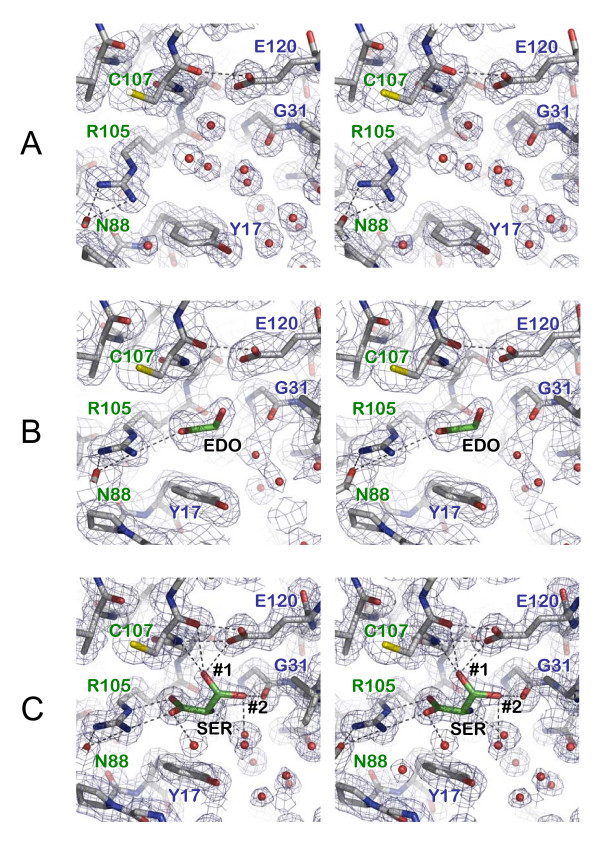
The ligand-binding pocket of TdcF in the empty, ethylene glycol-bound and serine-bound states. Stereoviews showing 2mFobs - dFcalc electron density maps contoured at approximately 1 sigma superposed on TdcF binding pockets in the following states: (A) empty (1.6 Å resolution); (B) with ethylene glycol bound (2.35 Å resolution); (C) with serine bound (1.6 Å resolution), where #1 and #2 denote alternate conformers for the Oγ. Important hydrogen bonds are shown as dashed lines. Residues from different subunits are labelled green and blue, respectively. In all cases, the side-chain of Arg-105 makes a bi-dentate interaction with the Oδ1 of Asn-88, which is just visible in the left foreground; and Oε1 of Glu-120 makes an inter-subunit hydrogen bond with the carbonyl oxygen of Cys-107. Throughout this figure, the view is similar to that seen in the inset of Figure 2. Figure generated using PyMOL [31].